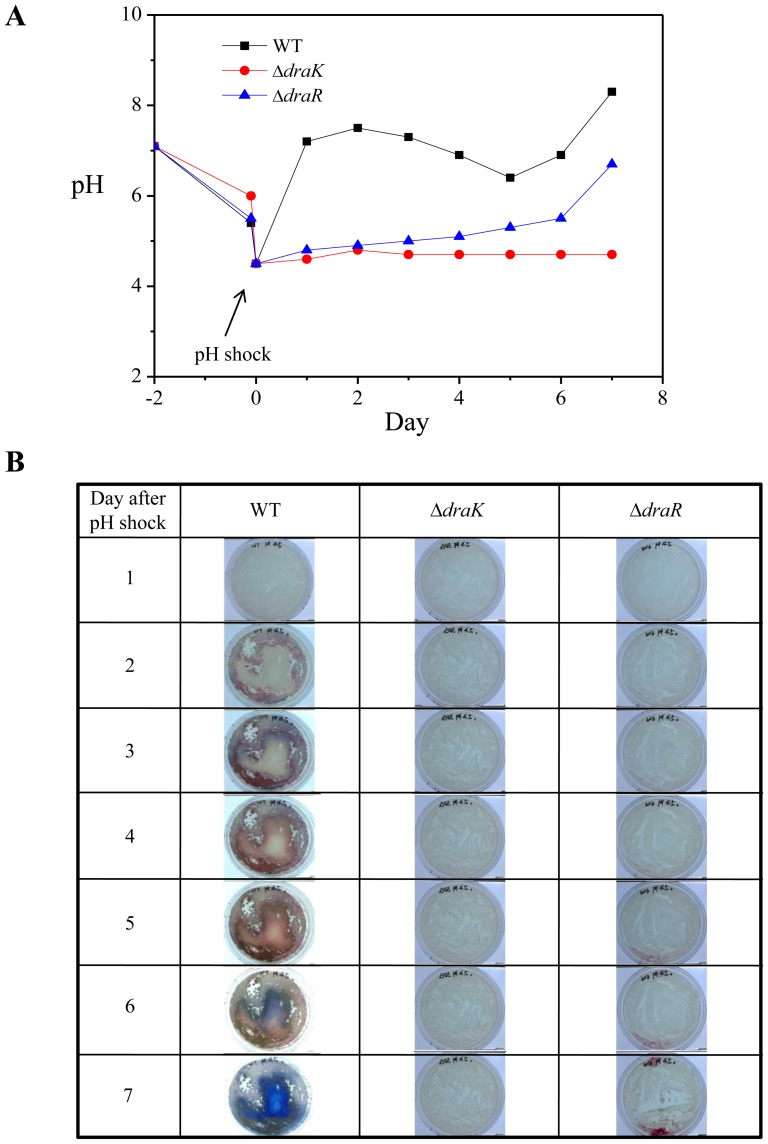
pH profiles and cell phenotypes.(A) Time-dependent pH profiles of culture plates for wild type DraK (black), the ΔdraK mutant (red), and the ΔdraR mutant (blue) following pH shock. (B) Time-dependent cell phenotypes of S. coelicolor for wild type DraK, the ΔdraK mutant, and the ΔdraR mutant in pH shock culture (PSC).